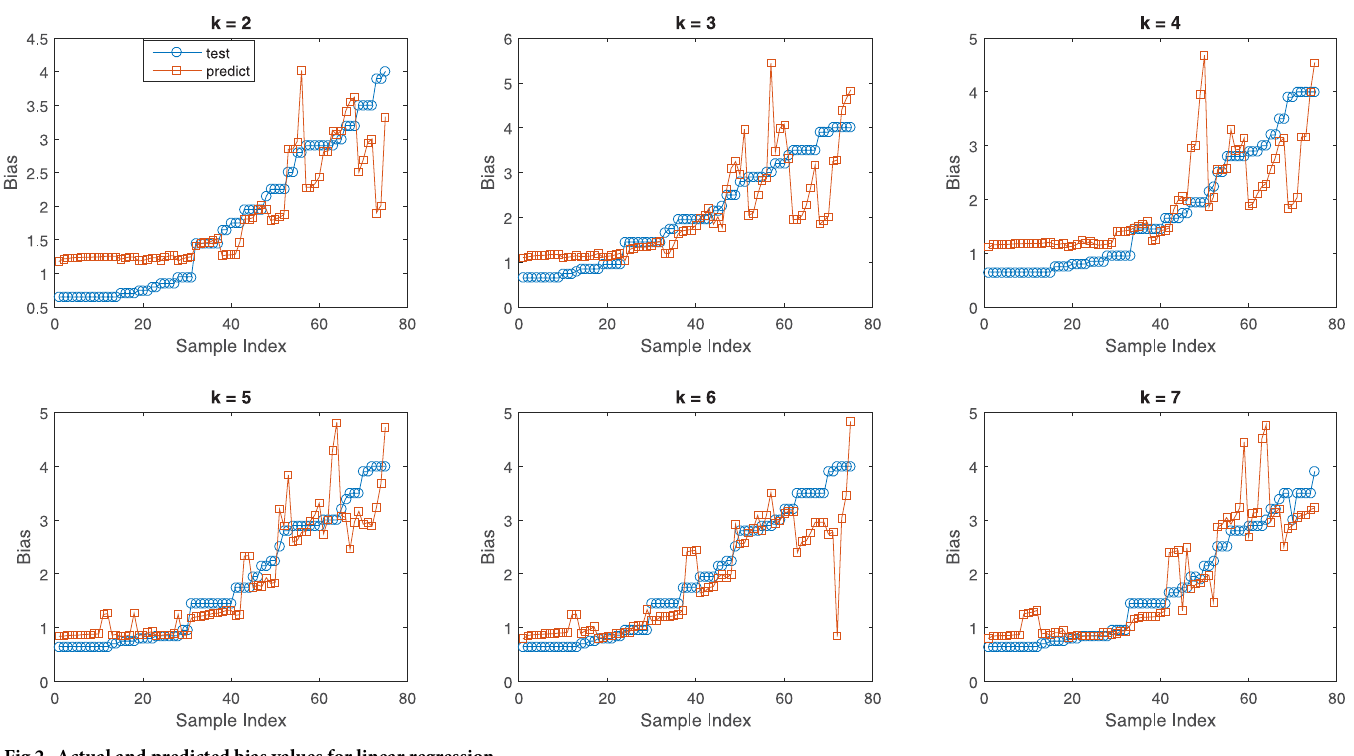
Fig 2. Actual and predicted bias values for linear regression.